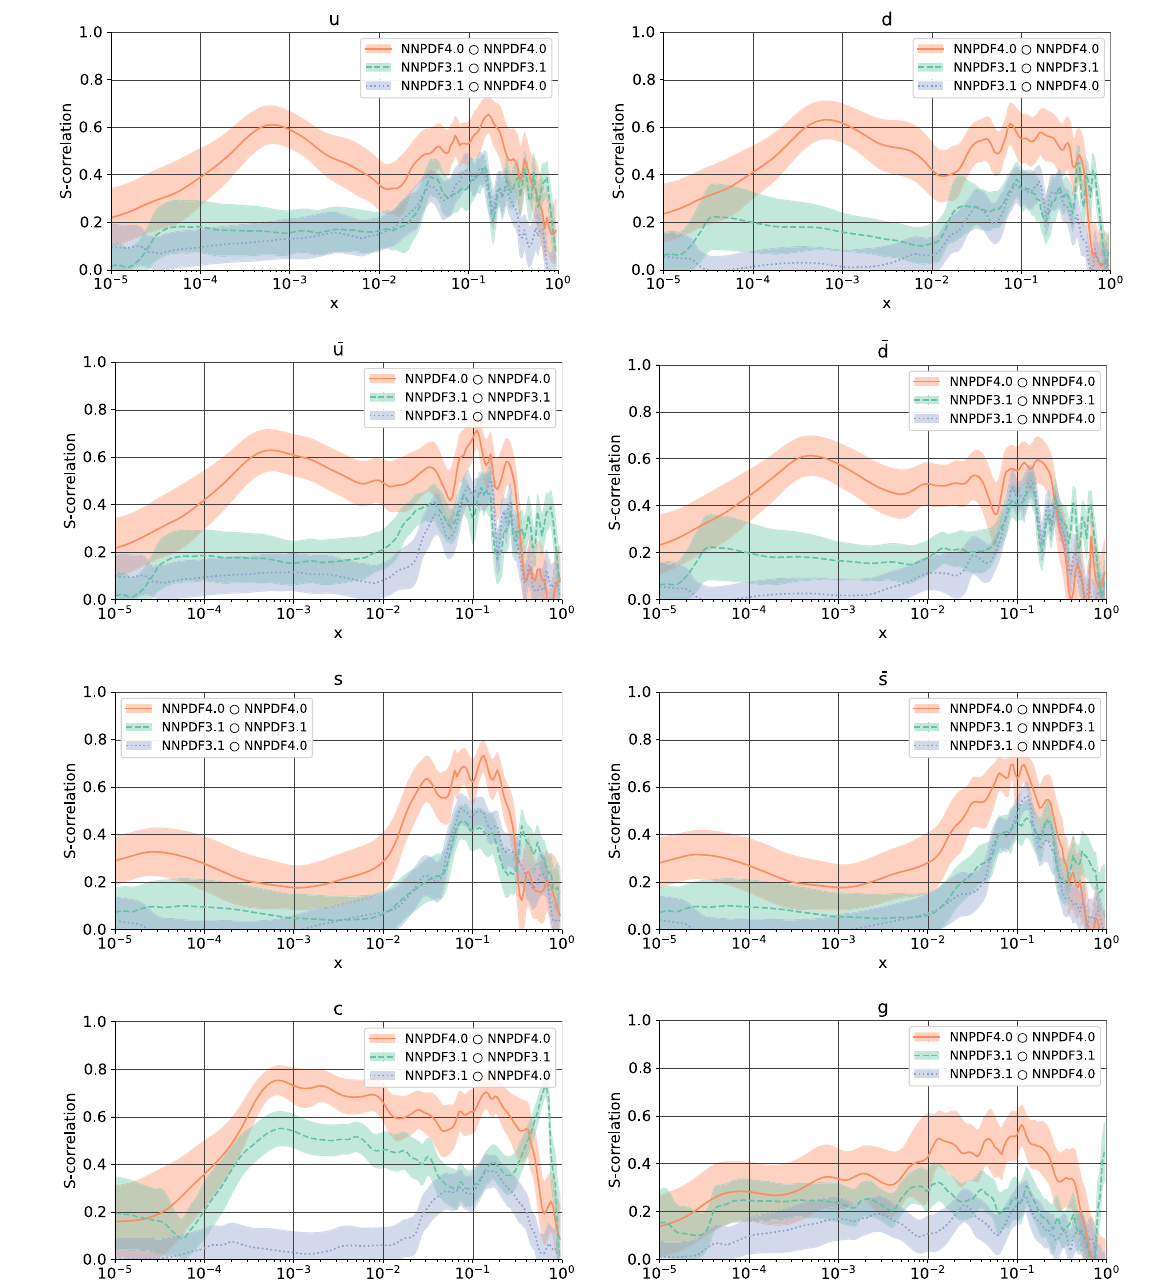
Fig. 4 The data-driven component of the S-correlation Eq. (12). Results are shown for all PDF flavors and the gluon. We consider PDF sets determined with the NNPDF3.1 methodology or the NNPDF4.0 methodology, and the three curves shown correspond to comparing pairs of sets with either methodology to themselves (NNPDF3.1: green; NNPDF4.0: orange) or with each other (blue). The shaded band for